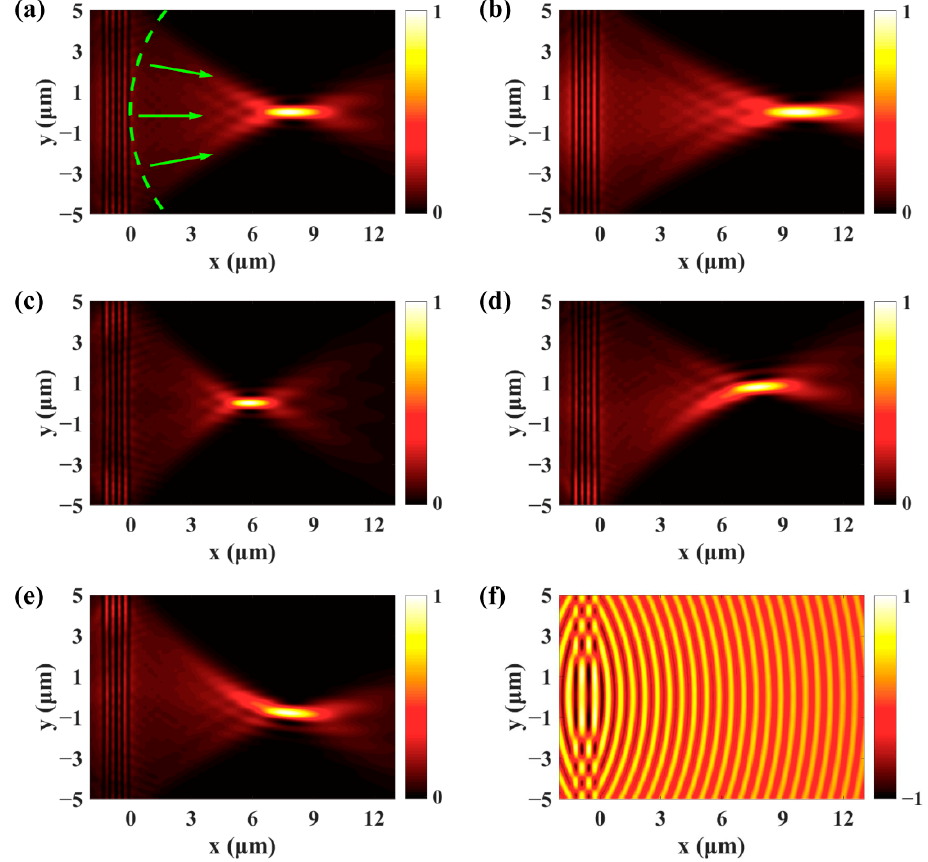
Figure 4. ( a ) The plasmonic grating can function as a SPPs lens by encoding a spherical phase on the SLM. ( b – e ) The position of the SPPs focus can be precisely controlled by changing the parameter f and α . ( f ) The polarity of the SPPs lens can be tuned from convex to concave.